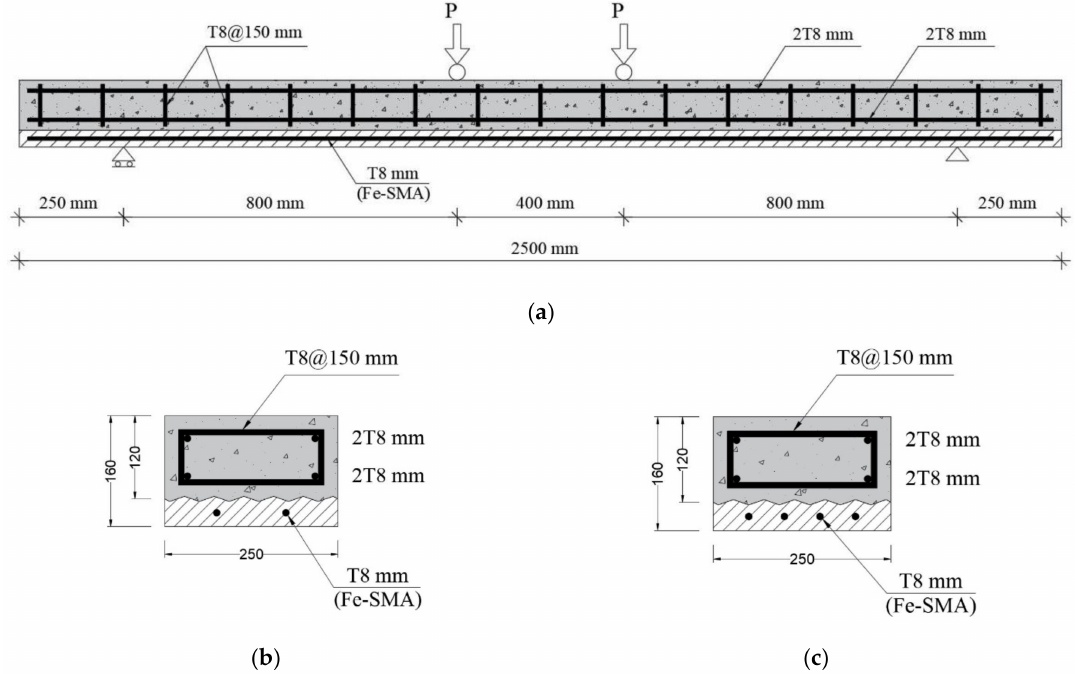
Figure 1. Beam details in ( a ) elevation and cross-section of ( b ) beam 10 (strengthened by 2T8 mm Fe-SMA bars) and ( c ) beam 11 (strengthened by 4T8 mm Fe-SMA bars)